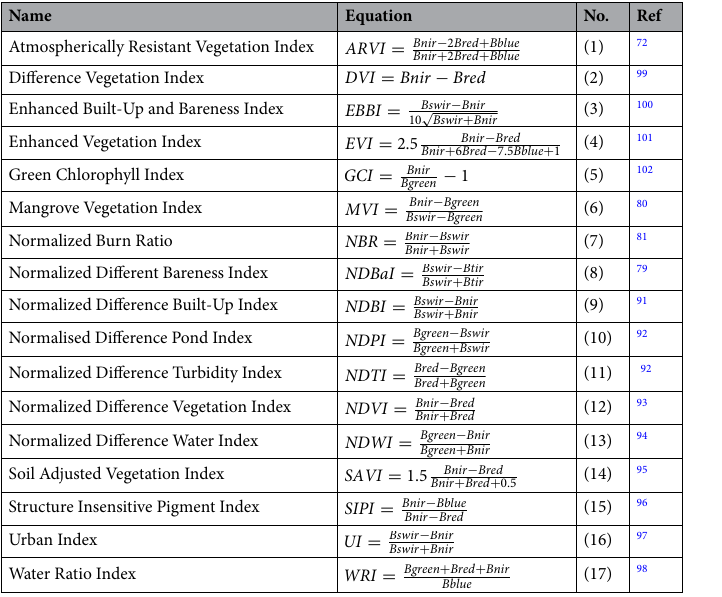
Table 4. Spectral indices derived from Landsat TM, ETM + and OLI, and Sentinel MSI satellite images to enhance the accurate performance of Vietnam-wide annual LULC mapping from 1990 to 2020.